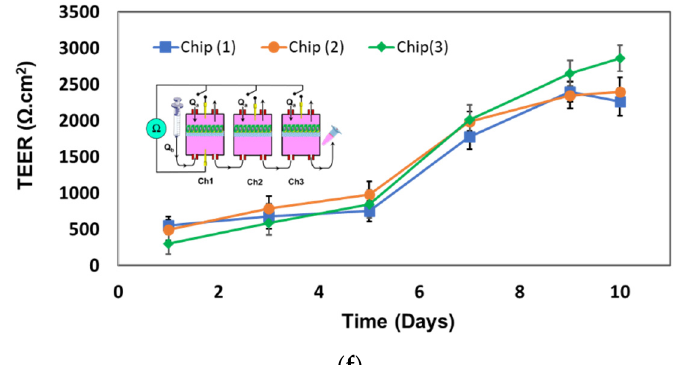
Figure 6. ( a ) Three chip assembly of each comprised one basolateral and detailed view of the through compartment fluidic connection. ( b ) Caco-2 cells formed a fully confluent layer on top of a PET membrane. The images were taken from the apical side of the chips. ( c ) Cell viability (at day 6) in the various compartments all showed acceptable viability. ( d ) Fluorescent intensity due to the diffusion of FITC-dextran 4 kDa through the caco-2 cell layer(s) in three-chip assembly connected through the basolateral compartments. ( d ) Two-chips assembly with an apical-basolateral connection. ( e ) The measured TEER values of the caco-2 monolayer against time in the three-chip assembly. The TEER increases with time due to the cell’s continuous growth and covering of the membrane surface. ( f ) The TEER was measured in individual chips. A Student t-test was used for statistical analysis. p < 0.05 was considered significant.